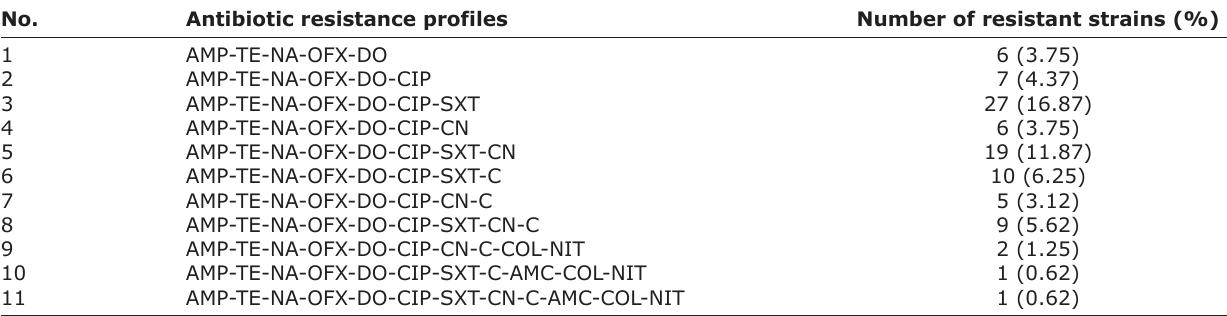
Table-3: Multidrug resistance patterns of the isolated APEC (n = 160).